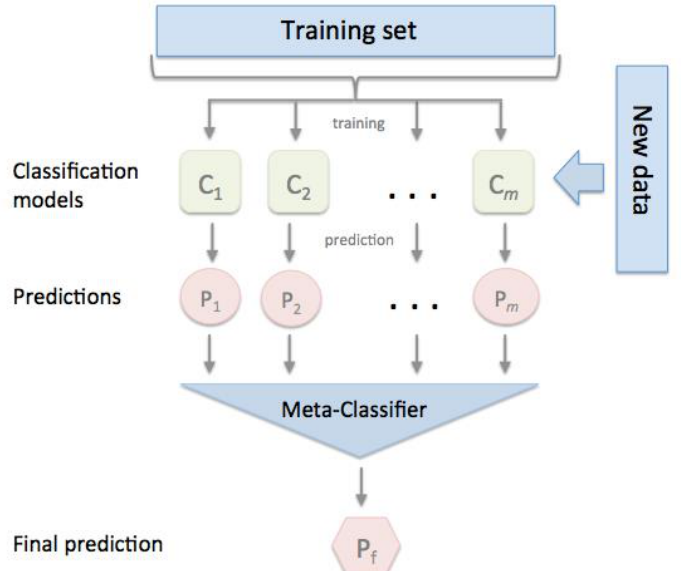
Figure 8. Flow Chart of Stacking Classification ensemble.